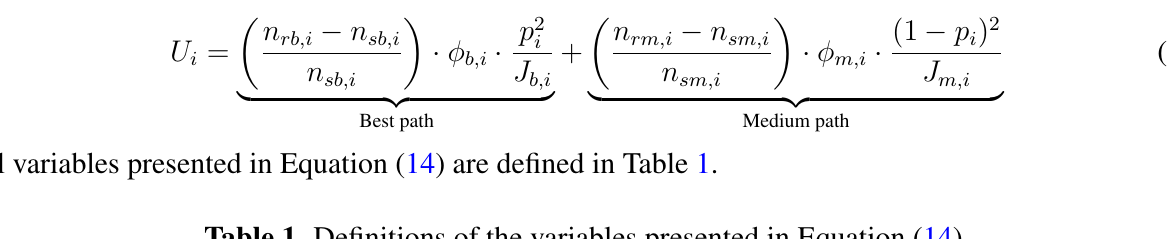
Table 1. Definitions of the variables presented in Equation